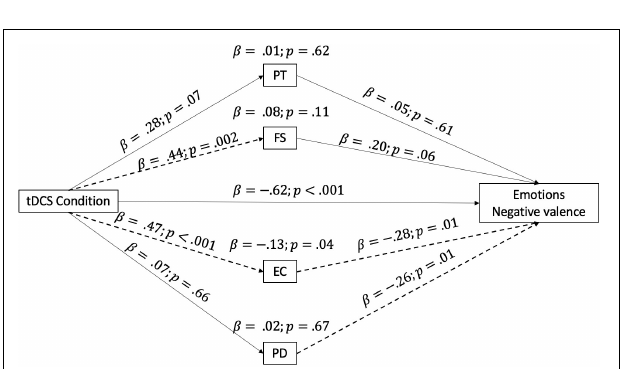
FIGURE 3 | Mediation model taking into consideration the IRI subscales as mediators of the relationship between the tDCS condition and the self-report of emotions (negative valence). The arrow indicates the direction of the mediation, and the dotted lines highlight significant mediation effects. IRI subscales: PT, perspective taking; FS, fantasy; EC, empathic concern; PD, personal